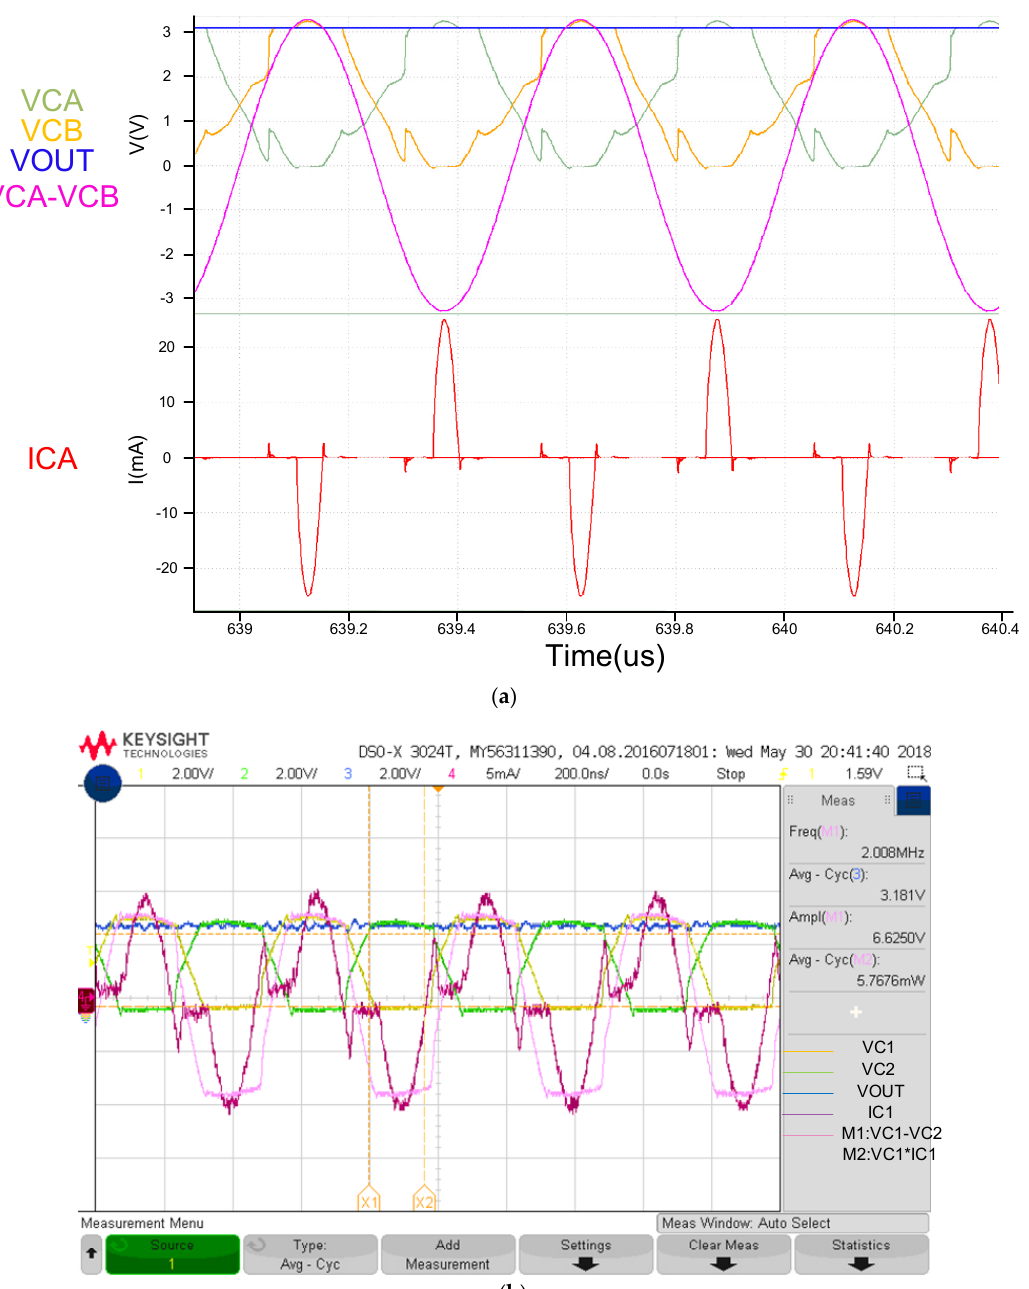
Figure 29. Actual measurement board ( 𝑅 (cid:3013) = 1 kΩ ).